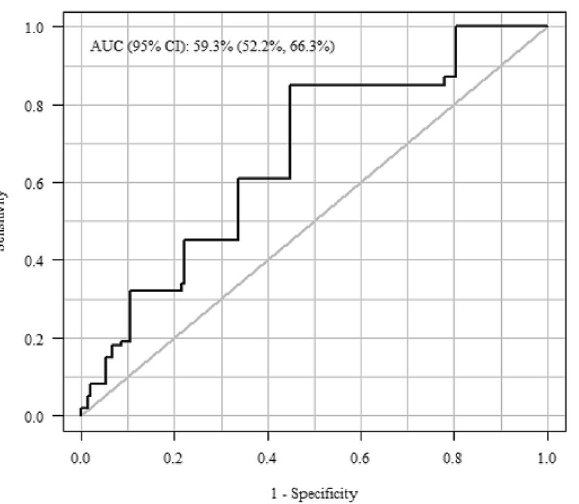
Figure 2. Receiver operator curve for the performance of the EUROMACS right ventricular risk score in an external, validation cohort. AUC: area under the curve, with 95% confidence